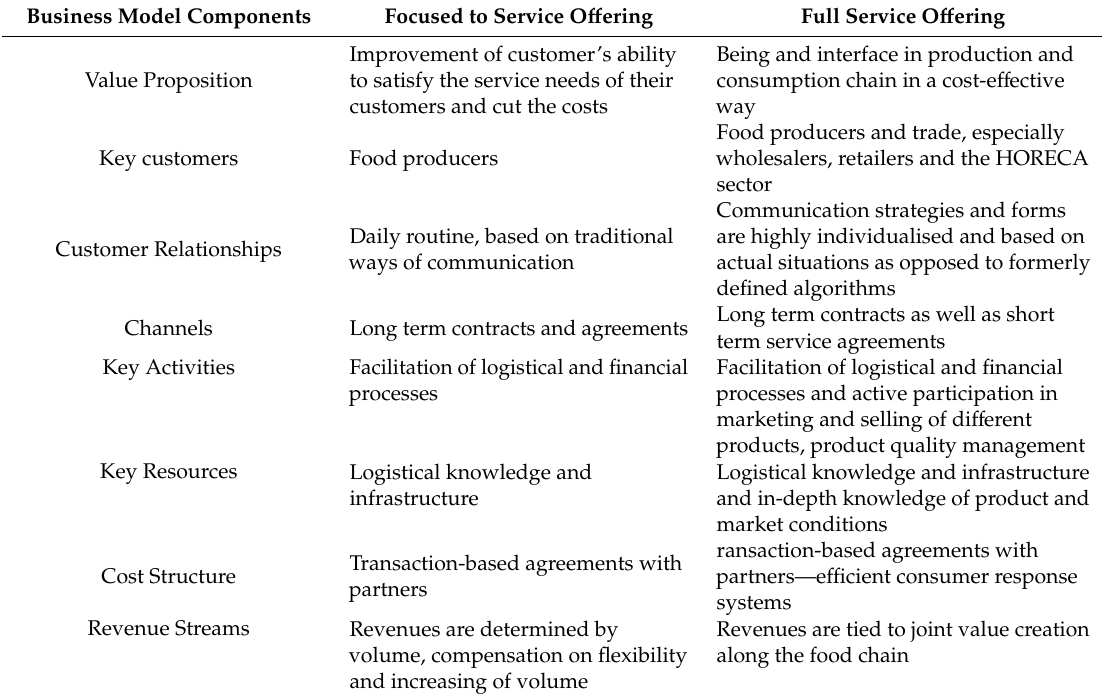
Table 5. The di ff erence between focused and full-service o ff ering business